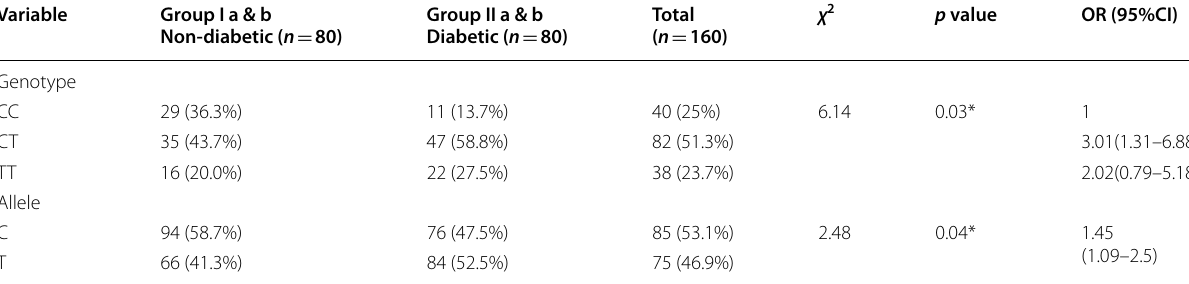
Table 2 Comparison of IL28B genotype and allele between non‑diabetic and